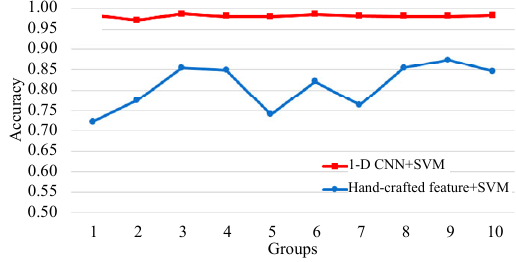
Fig. 36 Ten-fold-cross evaluation for the proposed method and the conventional machine learning method.